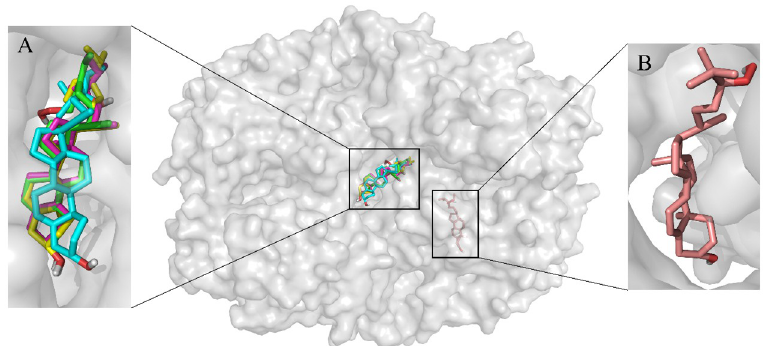
Fig 5. Molecular docking of COX-2 with compounds 1–5. Different compounds were located in different active pockets. Compounds 1, 2, 3 and 4 were located in the hydrophobic pocket A of COX-2 (Comp. 1 shown in green, Comp.2 shown in cyan, Comp.3 shown in magenta, Comp.4 shown in yellow), while compound 5 was located in the pocket B (Comp.5 shown in